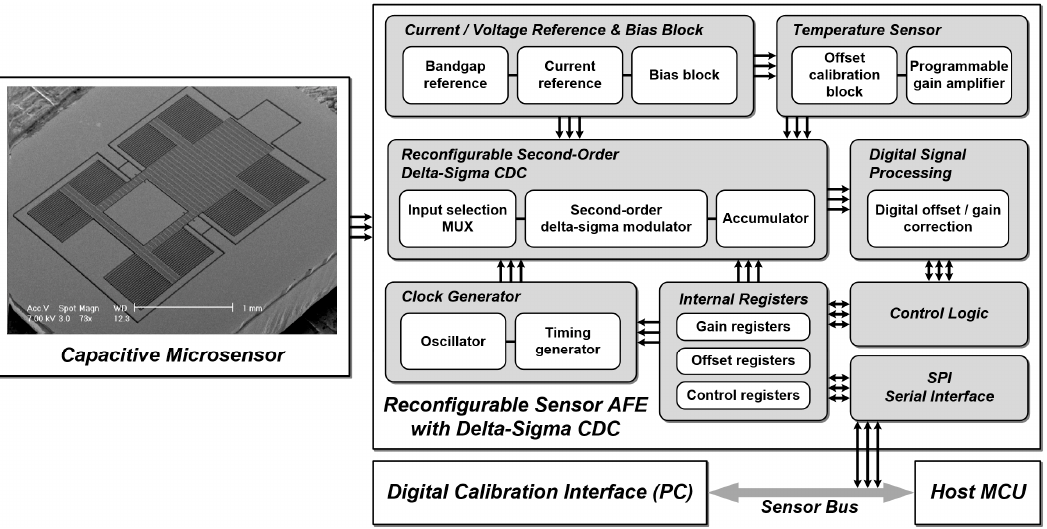
Figure 1. Block diagram of the proposed reconfigurable sensor analog front-end.